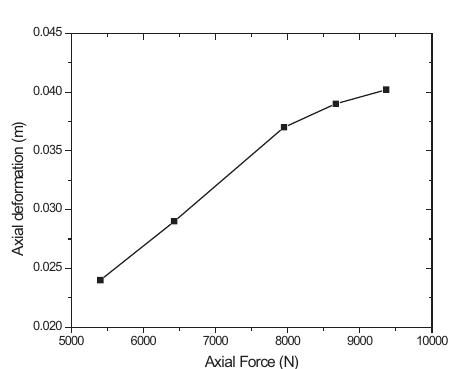
deformationFigure 13. First 10 modes with lift, gravity and centrifugal